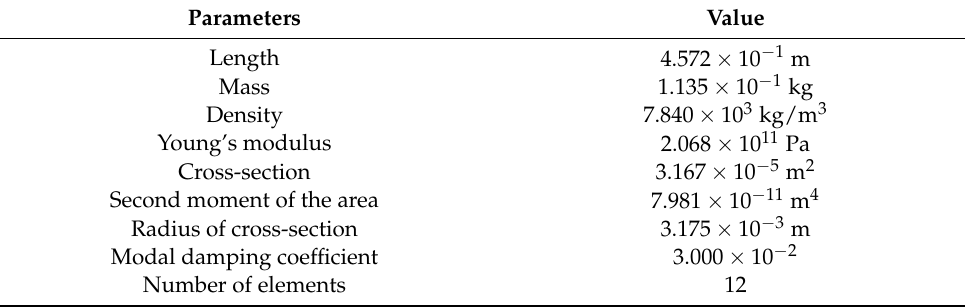
Table 1. Structural